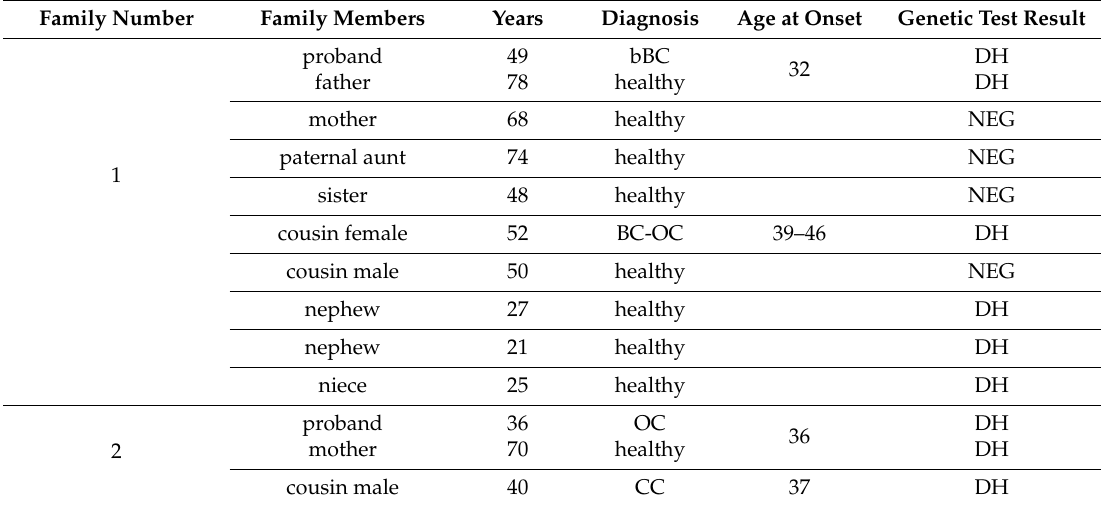
Table 3. Families tested for DH in BRCA1/2.